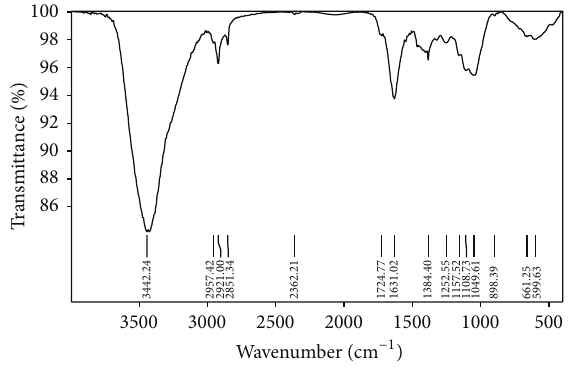
Figure 1: FT-IR spectrum of wheat